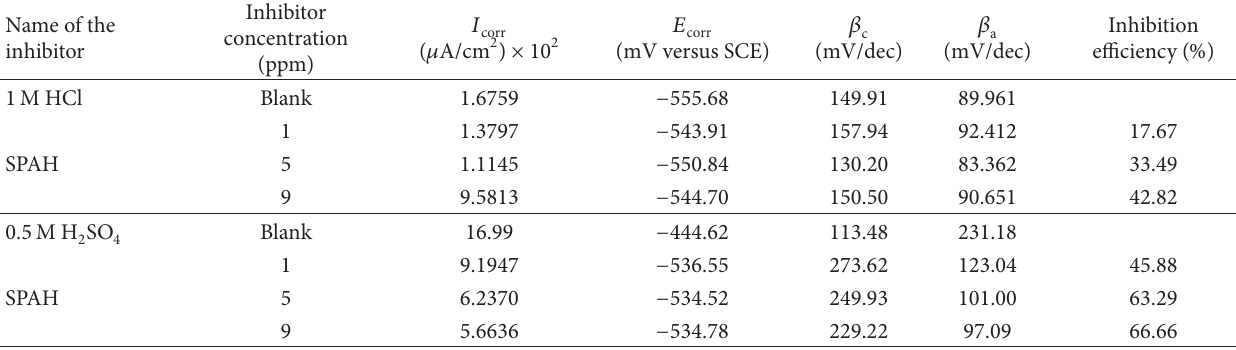
SO . 2 4 SO with and without 2 4